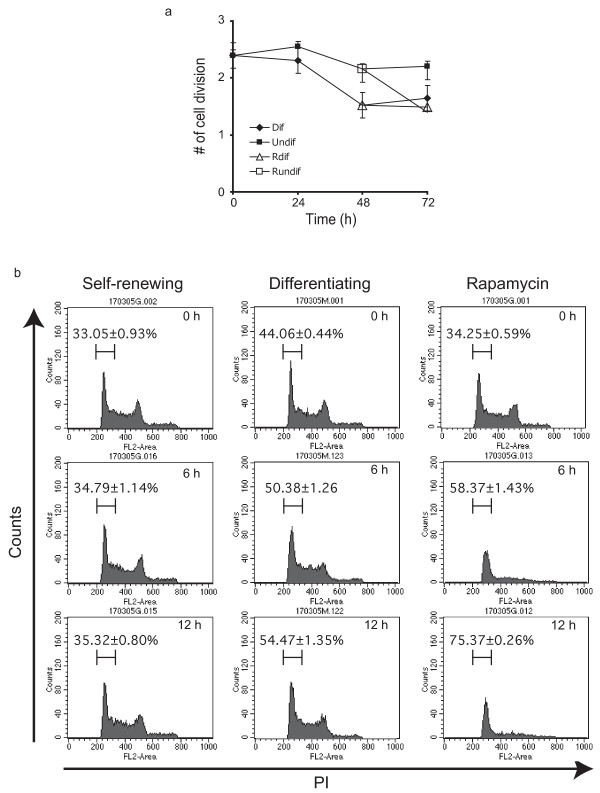
Growth and cell cycle regulation during endothelial differentiation and rapamycin treatment. a) Rate of cell division. RoSH2 cells were labeled with CFDA, a cell-permeant fluorescent dye, cultured for 24 hours and re-plated on gelatin-coated plates to be maintained as undifferentiated cells (Undif) or on matrigel to induce differentiation (Dif). Cells were harvested at 0, 24, 48 and 72 hours. At 48 hours after replating, half of the remaining plates of cells under undifferentiating condition or differentiating condition were treated with 50 ηM rapamycin (R undif and Rdif, respectively). Median cellular fluorescence of the harvested cells was measured by flow cytometry and the number of cell divisions was calculated as a function of the loss in fluorescence; b) Cell cycle progression during endothelial differentiation. RoSH2 cells were plated on either gelatin-coated plate (self-renewing) or matrigel (differentiating) and labeled with BrdU for 16 hours. After removing BrdU, half of the gelatin-coated plates were treated with 50 ηM rapamycin. At 0, 6 and 12 hours, cells were harvested, stained with anti-BrdU and PI. DNA content of BrdU-labeled cells as measured by PI was analyzed by flow cytometry.